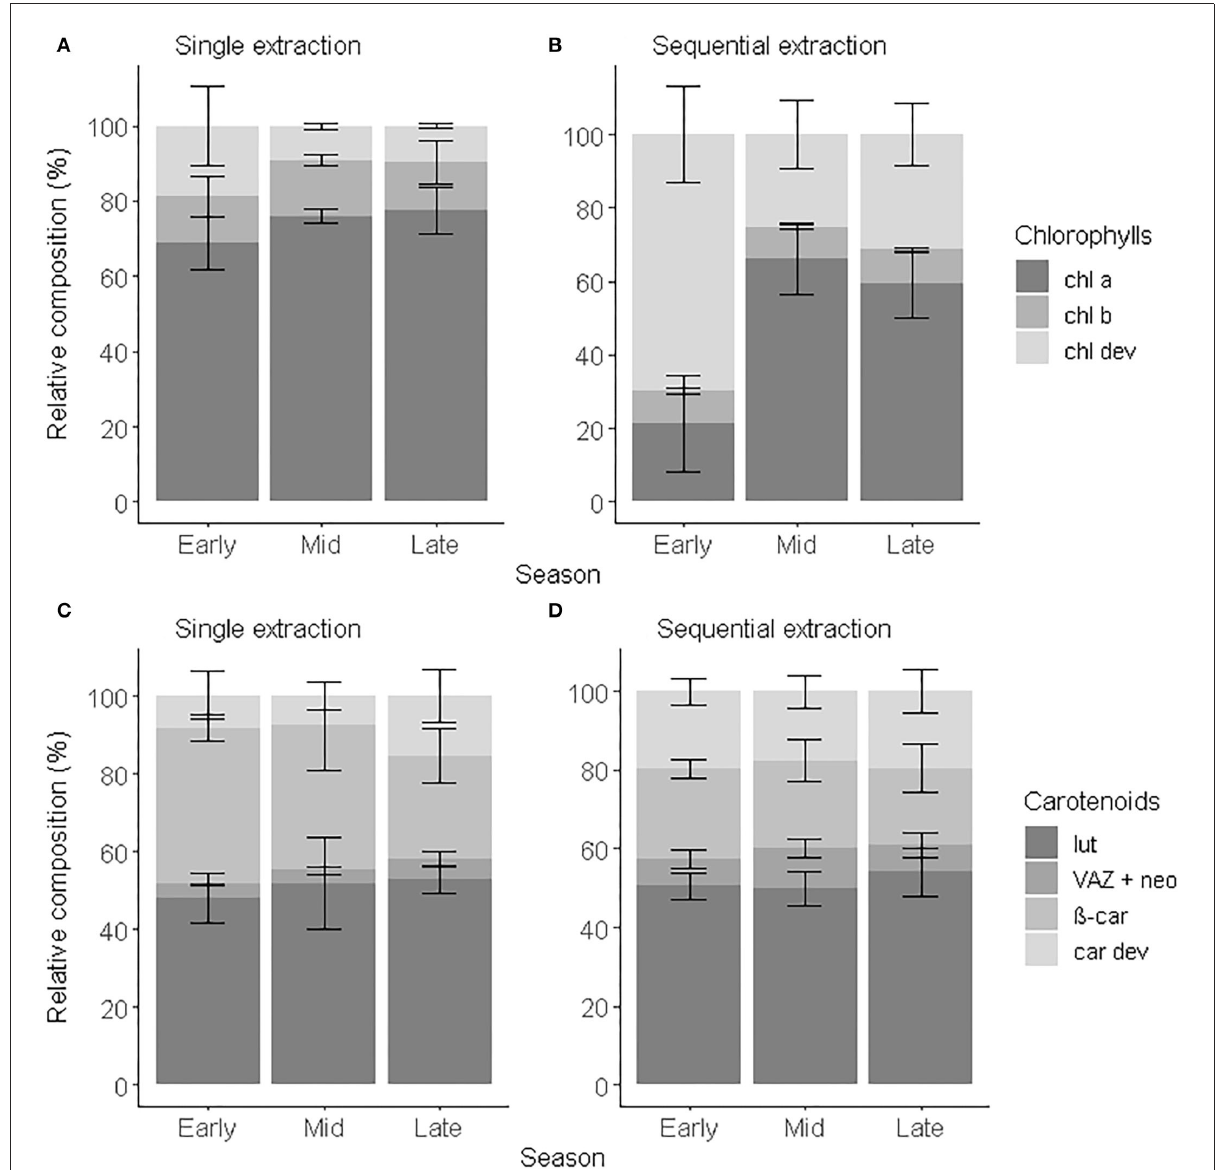
FIGURE4 Relative composition of chlorophylls (A,B) and carotenoids (C,D) of beech leaves in early (May to June), mid (July to August), and late (September to November) growing season 2018 obtained after a single extraction (A,C) and a sequential extraction (B,D) . Error bars correspond to standard deviations ( n =